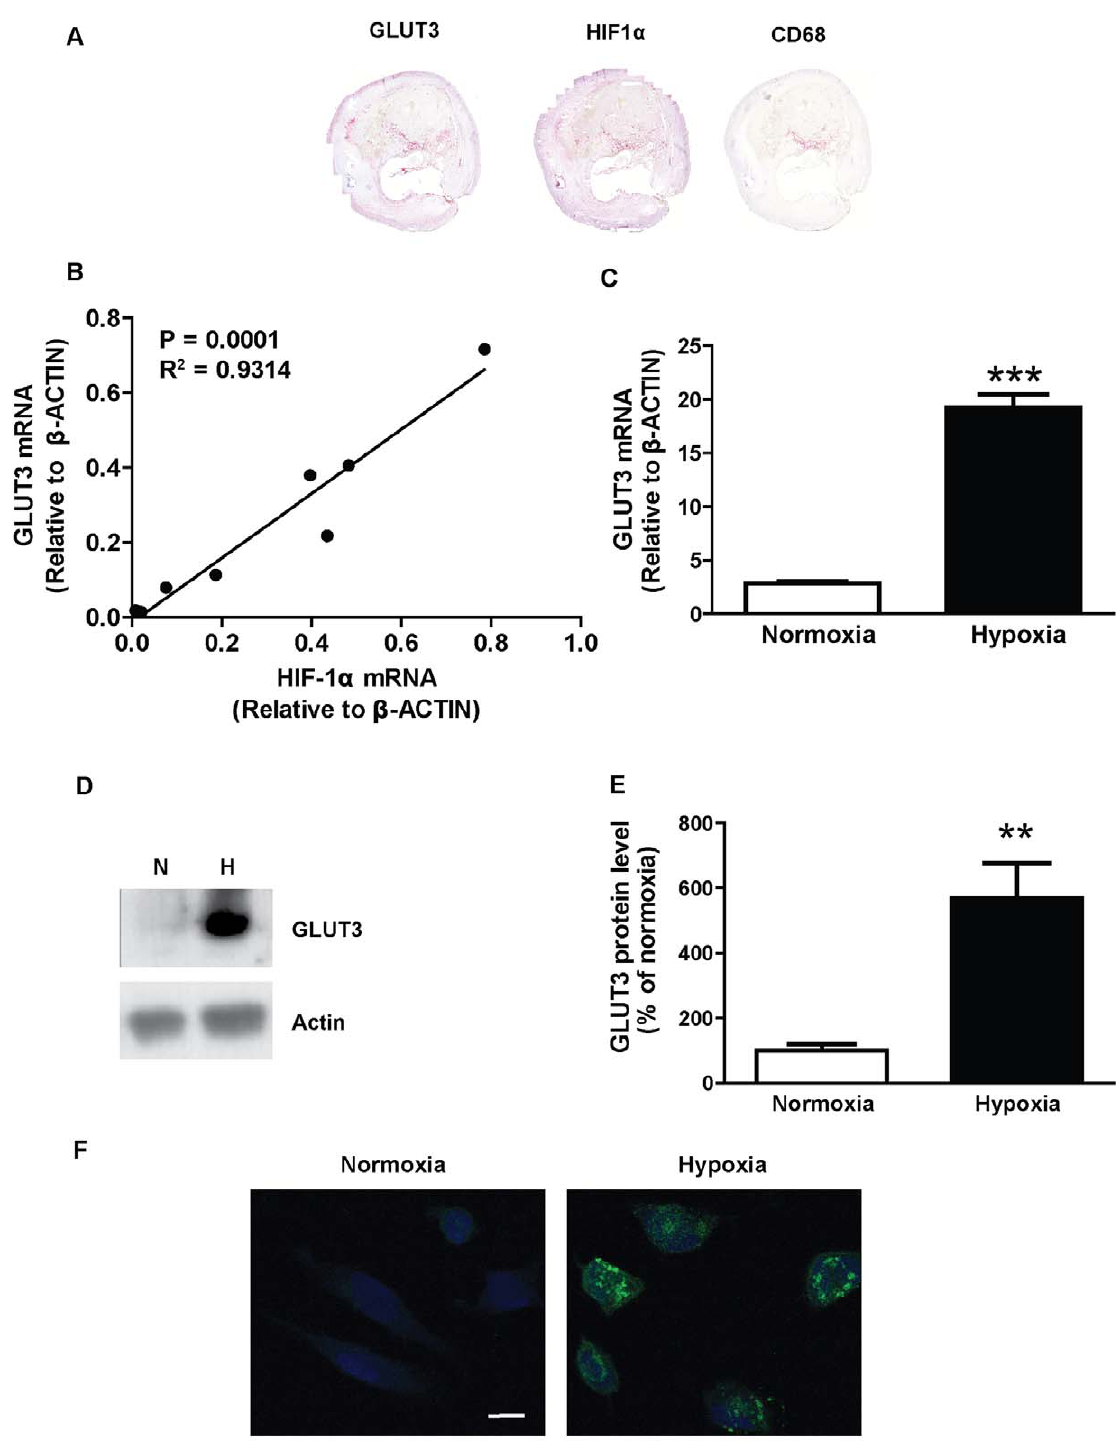
Figure 2. GLUT3 is abundant in macrophages isolated from human atherosclerotic plaques and in hypoxic human macrophages. ( A ) Representative immunohistochemical staining of sections of a human atherosclerotic carotid plaque with antibodies against GLUT3, HIF-1a´ and the macrophage marker CD68. ( B ) GLUT3 and HIF-1a ´ mRNA expression in CD14 + macrophages isolated from 8 human atherosclerotic carotid plaques. ( C – F ) GLUT3 mRNA and protein levels in human monocyte-derived macrophages cultured in medium containing 11 mmol/l glucose for 24 h in normoxia (21% O 2 ) or hypoxia (1% O 2 ). ( C ) Real-time RT-PCR analyses of GLUT3 mRNA expression. Data are mean 6 SEM from 6 macrophage donors. ( D ) Representative immunoblots of GLUT3 and tubulin in normoxic (N) and hypoxic (H) human macrophages. ( E ) Quantification of immunoblots. Data are mean 6 SEM from 6 macrophage donors. ( F ) Representative immunoflourescent images of macrophages cultured in normoxia or hypoxia and stained for GLUT3 (green) and nuclei (blue). Scale bar 10 m m. ** P , 0.01, *** P , 0.001 vs normoxia.